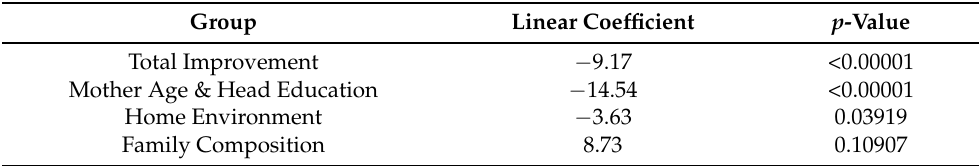
Table 2. Results coefficients of the linear regression to predict the variation in CM ( ∆ CM) based on the variation of the percentage of households with improved characteristics of the identified distal causes ( ∆